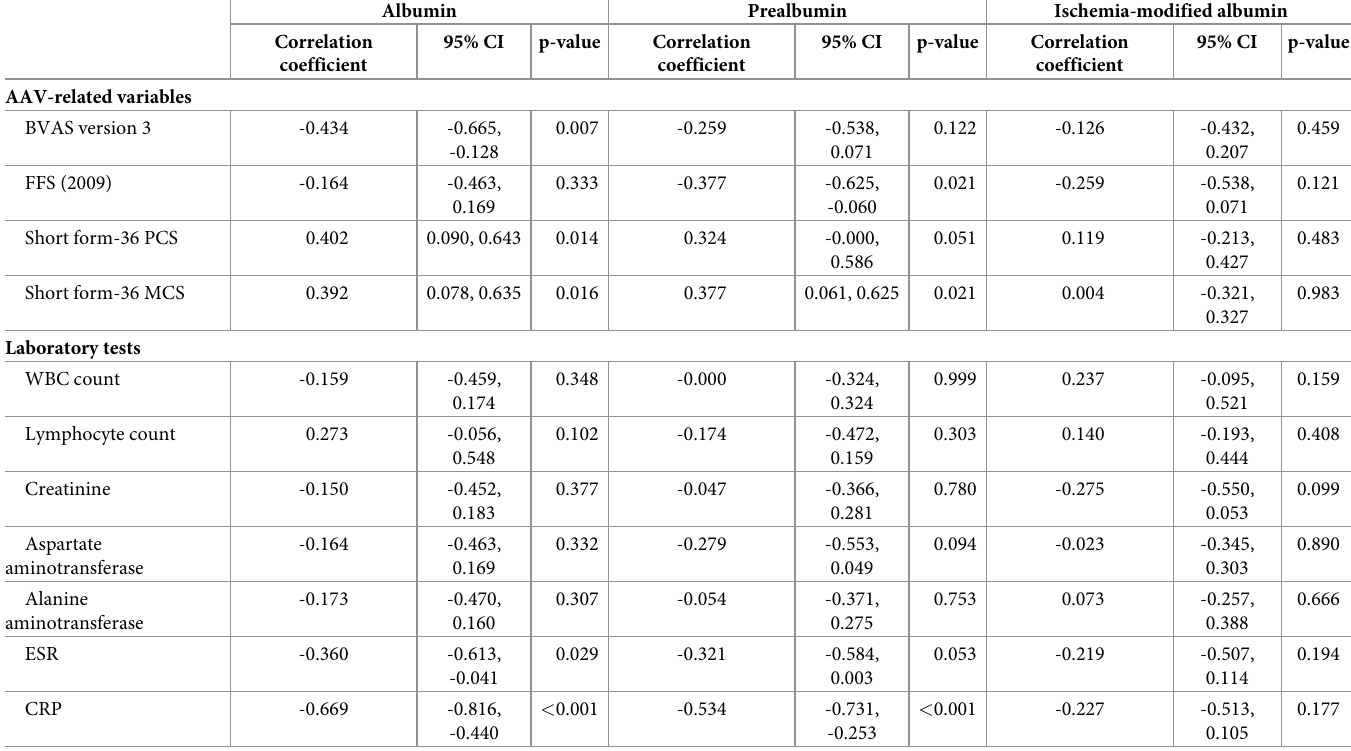
Table 3. Association of albumin, prealbumin, and ischemia-modified albumin with AAV-related variables and laboratory tests in new-onset AAV at baseline (n = 37).